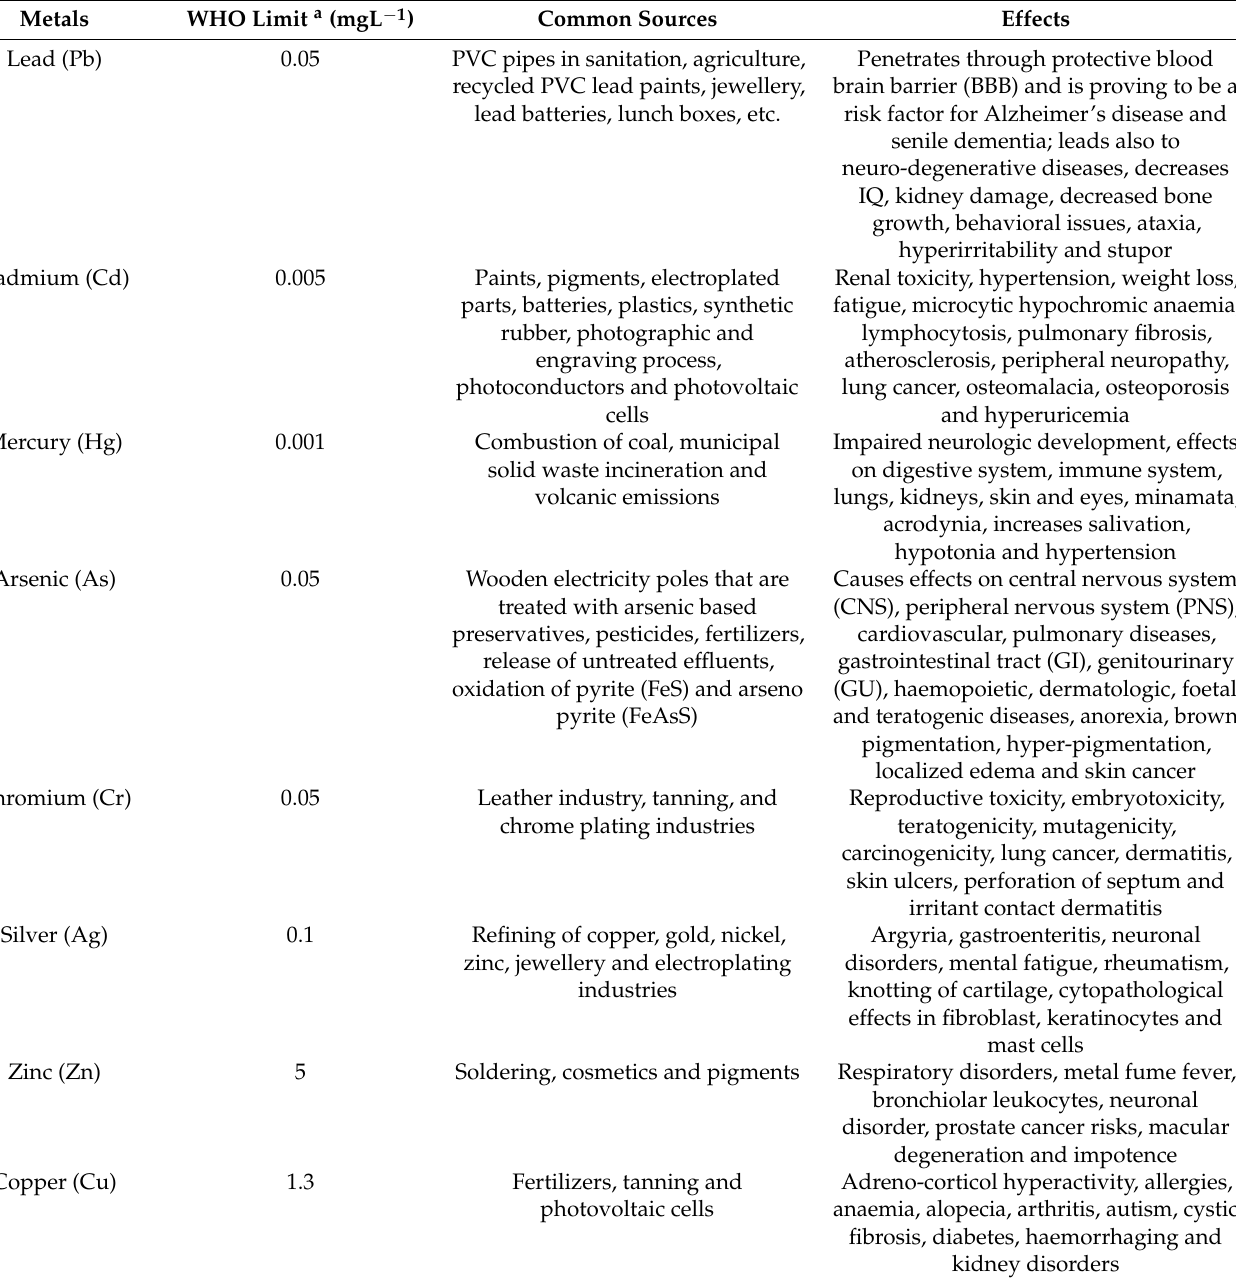
Table 1. Limit, sources, and effects of various heavy metal ion contaminations. Reprinted from [3], Copyright 2015, with permission from